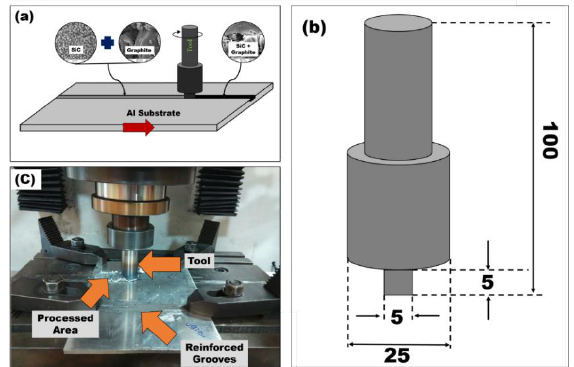
Figure 2 . Schematic representation of ( a ) grooved Al6061 sheet for reinforcement, ( b ) friction stir process (FSP) tool, and ( c ) processing setup.